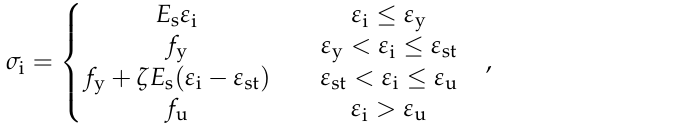
Figure 17. Confining mechanism of the steel tube to concrete in an L-shaped CFSST composite column with steel